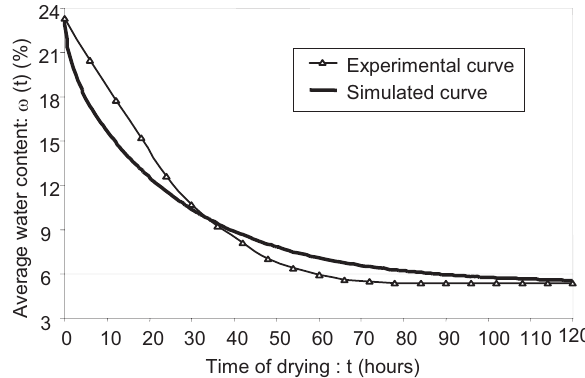
Fig. 11. Superimposition of the experimental curve and the simulated curve giving the average water content in the clay matrix during